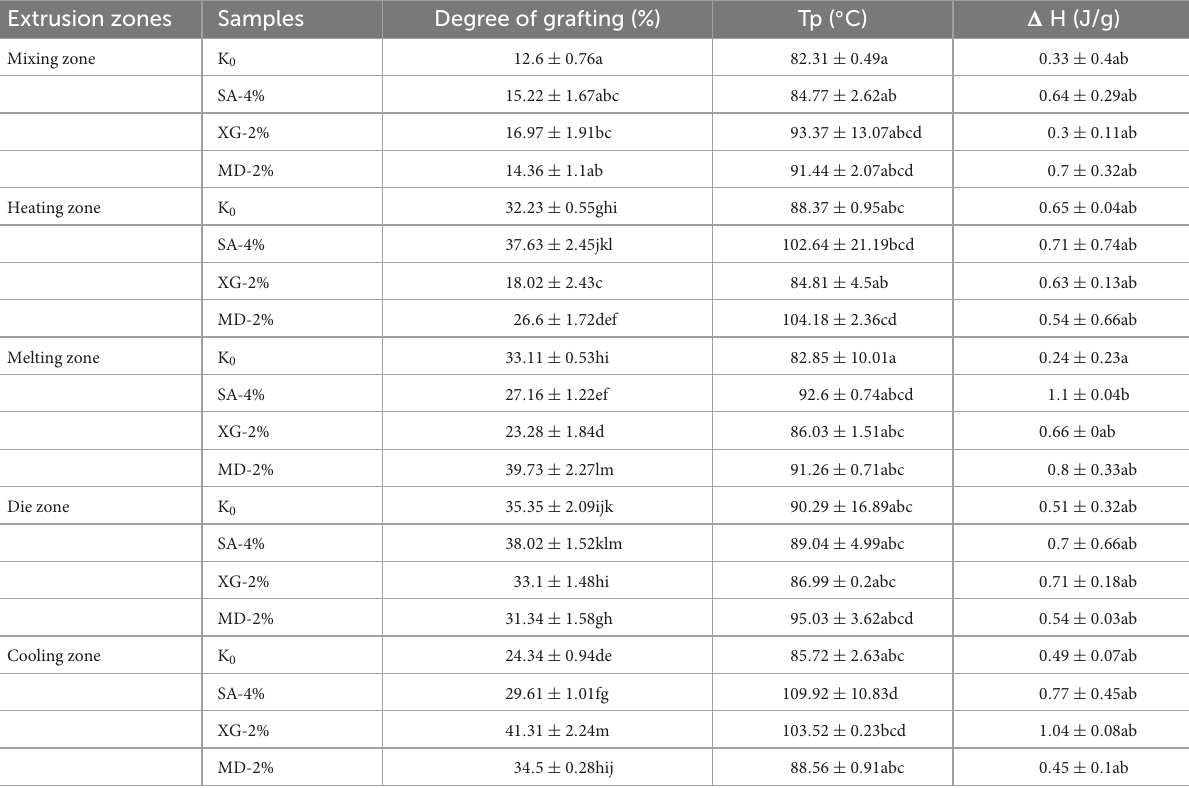
TABLE 3 Degree of grafting and thermal properties of extrudates in different zones, in table, respectively. Extrusion